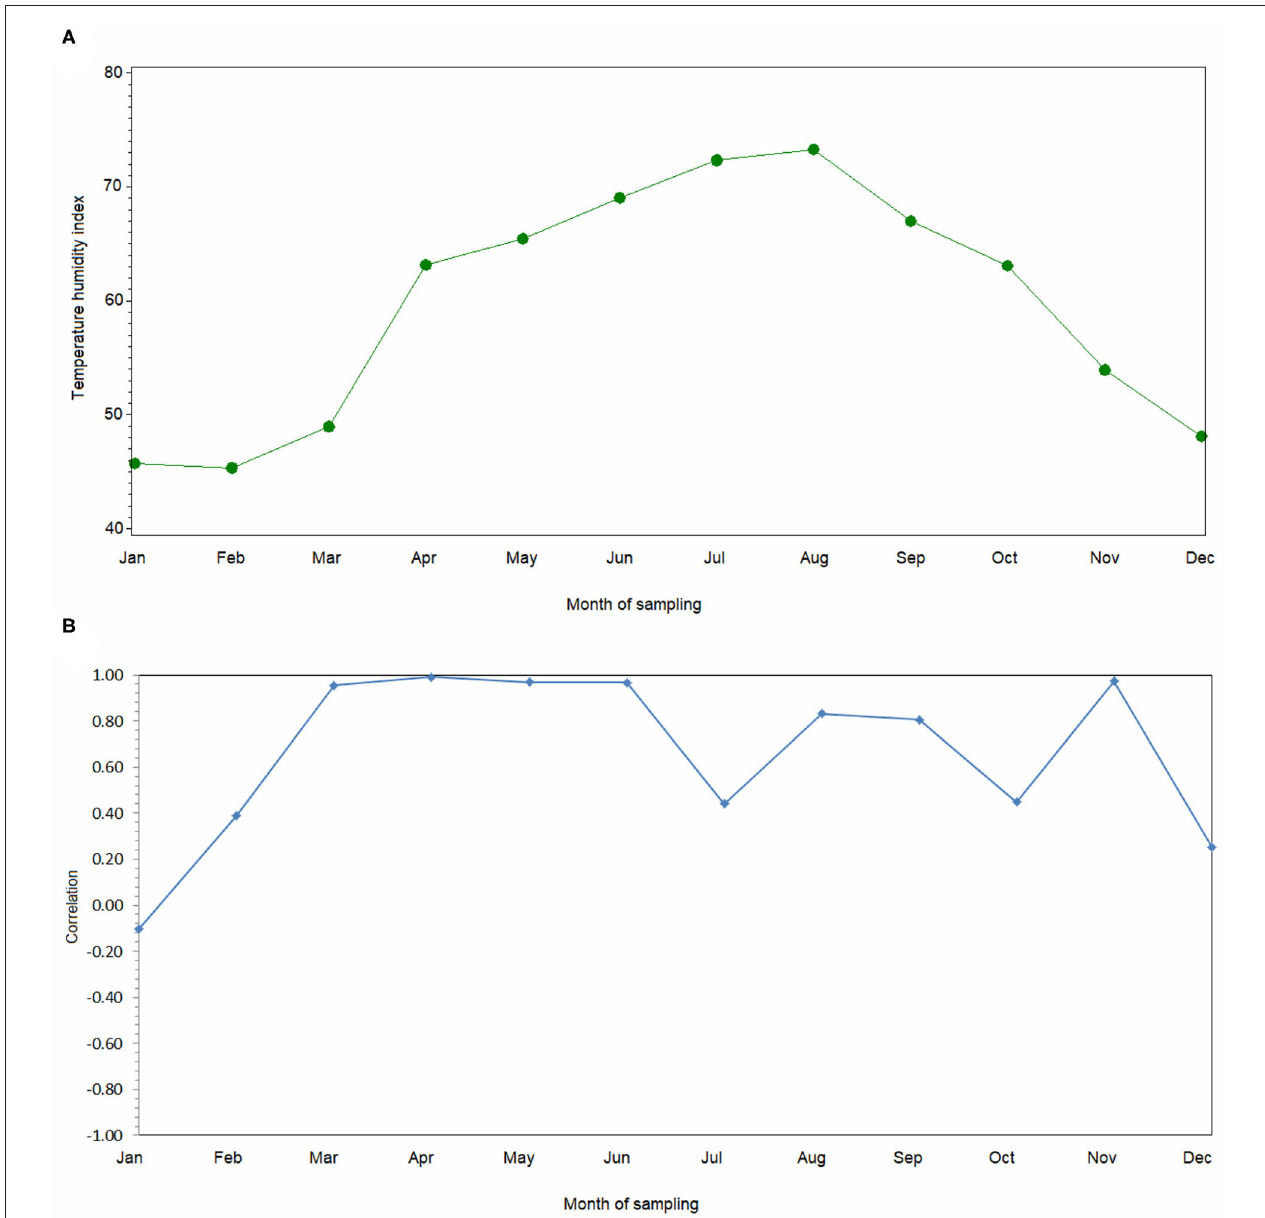
FIGURE 2 | Trend of (A) average temperature-humidity index and (B) correlation between temperature-humidity index and maximum temperature-humidity index during 2018.